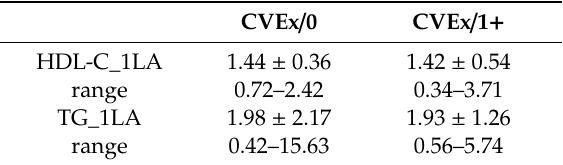
Table 2. HDL-C and TG levels (means, standard deviations, range; mmol / L) measured before the first LA session in both groups.